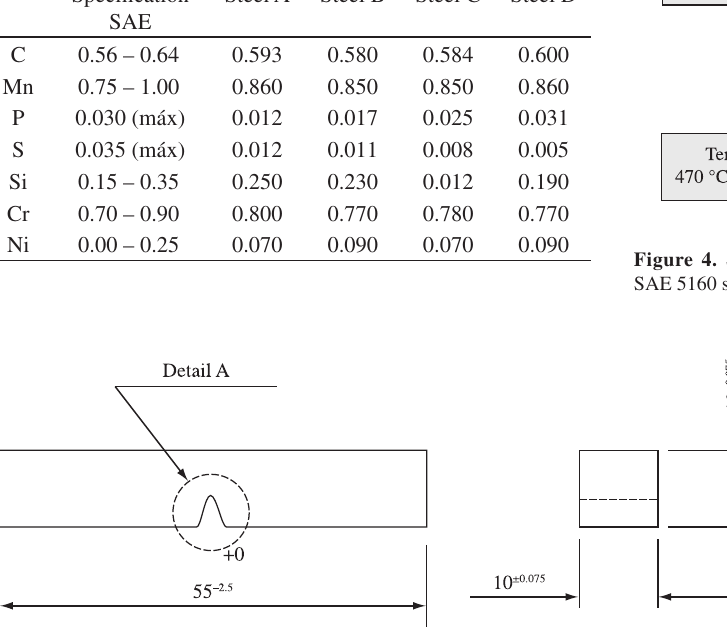
Table 1. Chemical composition of SAE 5160 steel wt.